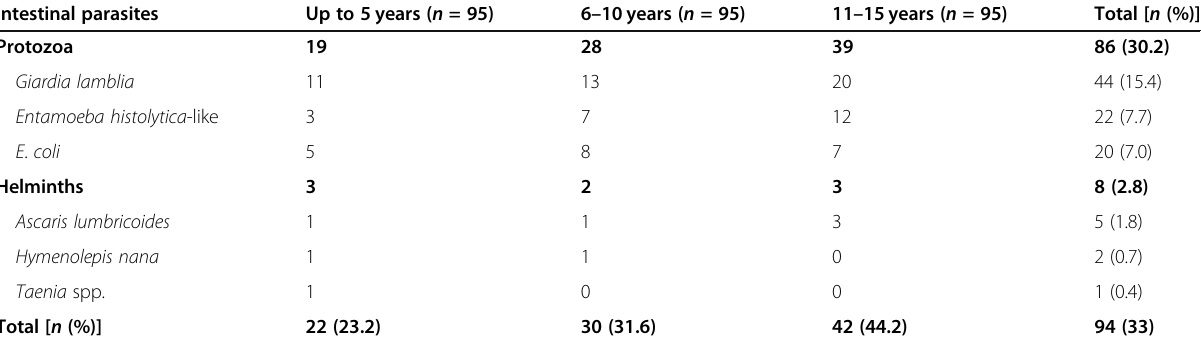
Table 1 Age-wise distribution of intestinal parasitic infections Intestinal parasites